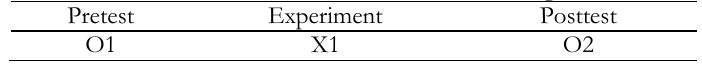
TABLE 1 . Research Design